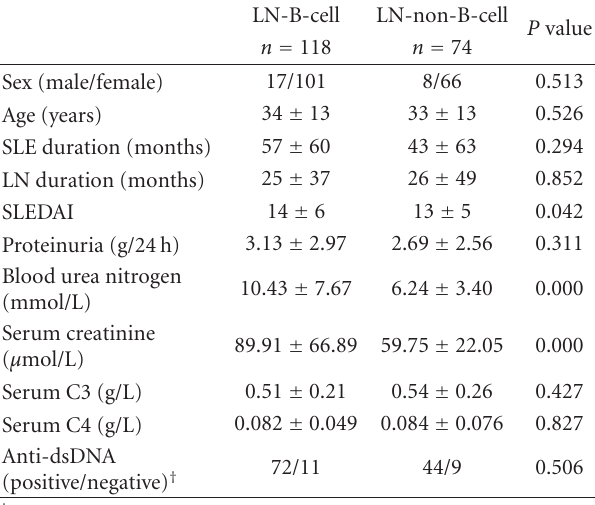
Table 2: Comparison of histologic parameters of LN-B-cell and LN-non-B-cell